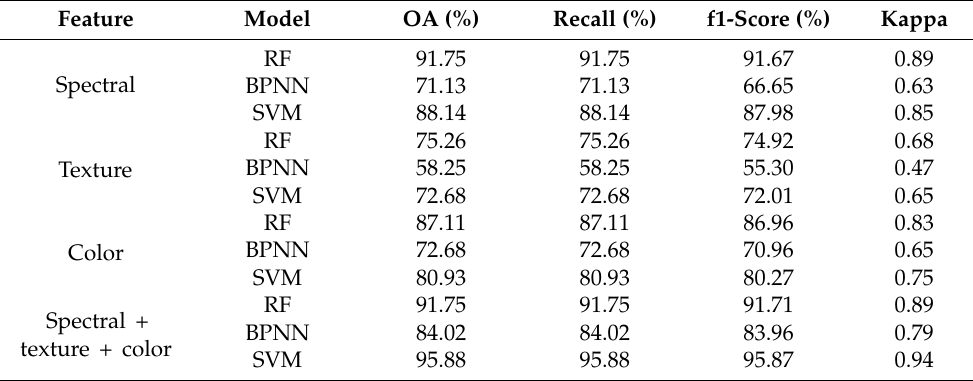
Table 7. The accuracy evaluation of different feature combinations and classification